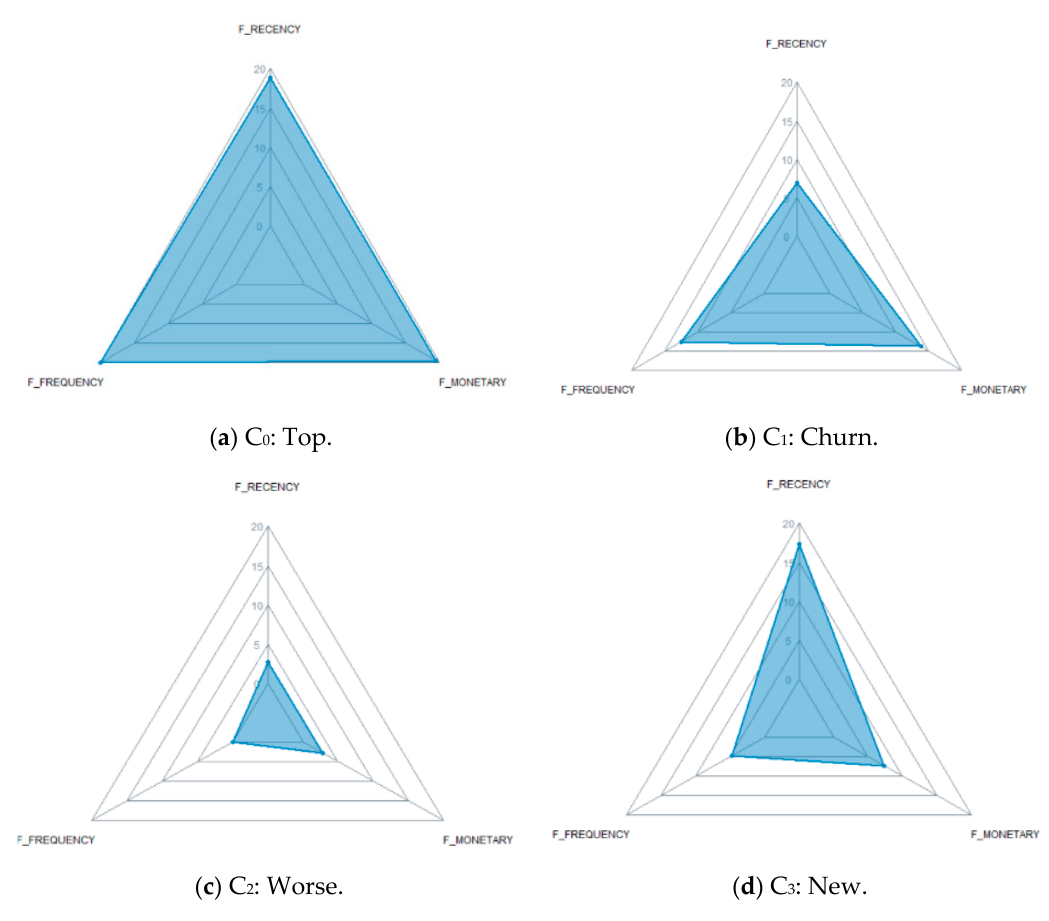
Figure 18. Radar plots per cluster.